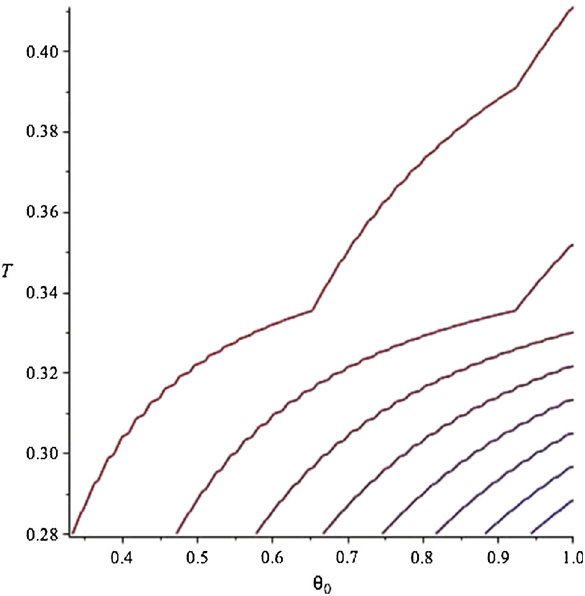
Fig. 1 Figures show contour plots of T = constant in V as functions of θ 0 . Different lines in each graph show a specific temperature